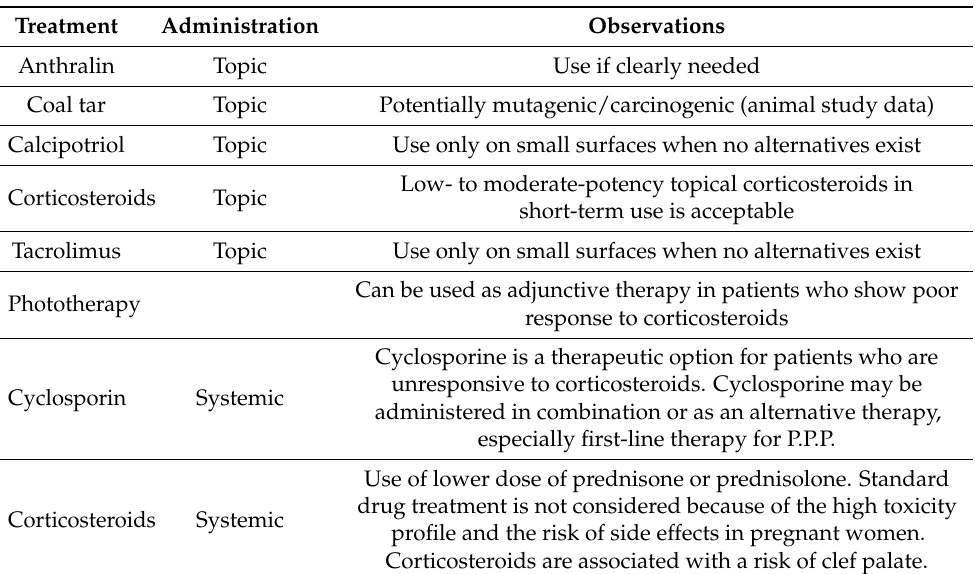
Table 4. Treatment options of psoriasis during pregnancy [32,78,84,95,104–106].